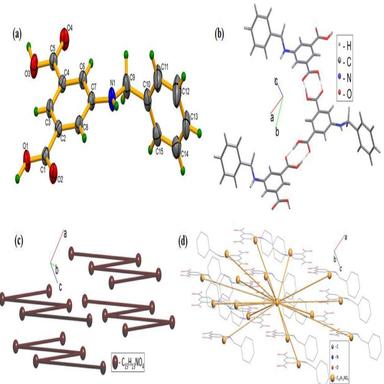
(a) Diagrammatic Ortep view of asymmetric unit with displacement ellipsoid drawn at 50% level, (b) The trimer structural fragments of molecular structure, (c) 2C1 topology of 2-c net in standard representation of H-bonded molecular structure, and (d) 16-c net in standard representation of Coulomb or vdW-bonded molecular structure (C15H13NO4: yellow balls) with molecule fragments. Hydrogen atoms are omitted for clarity.